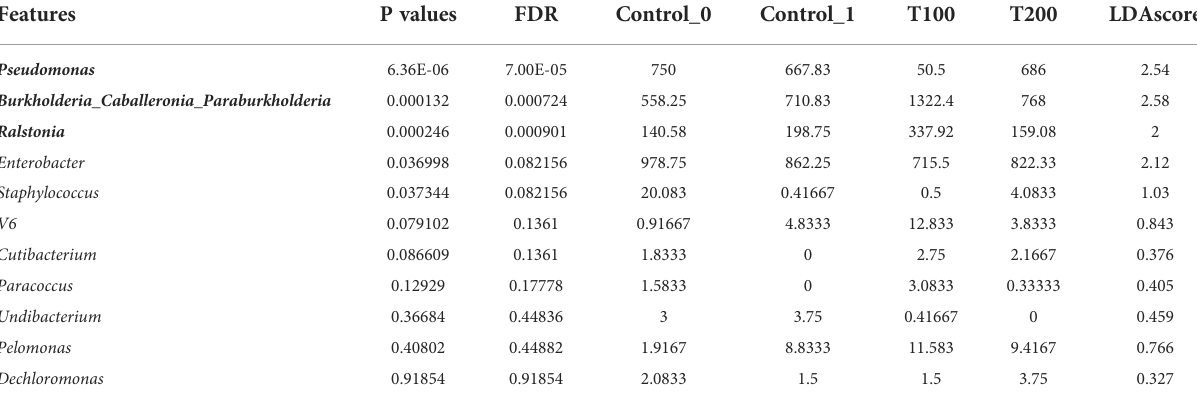
TABLE 3 Result from LEfSe analysis at the genus level (FDR cutoff = 0.05).